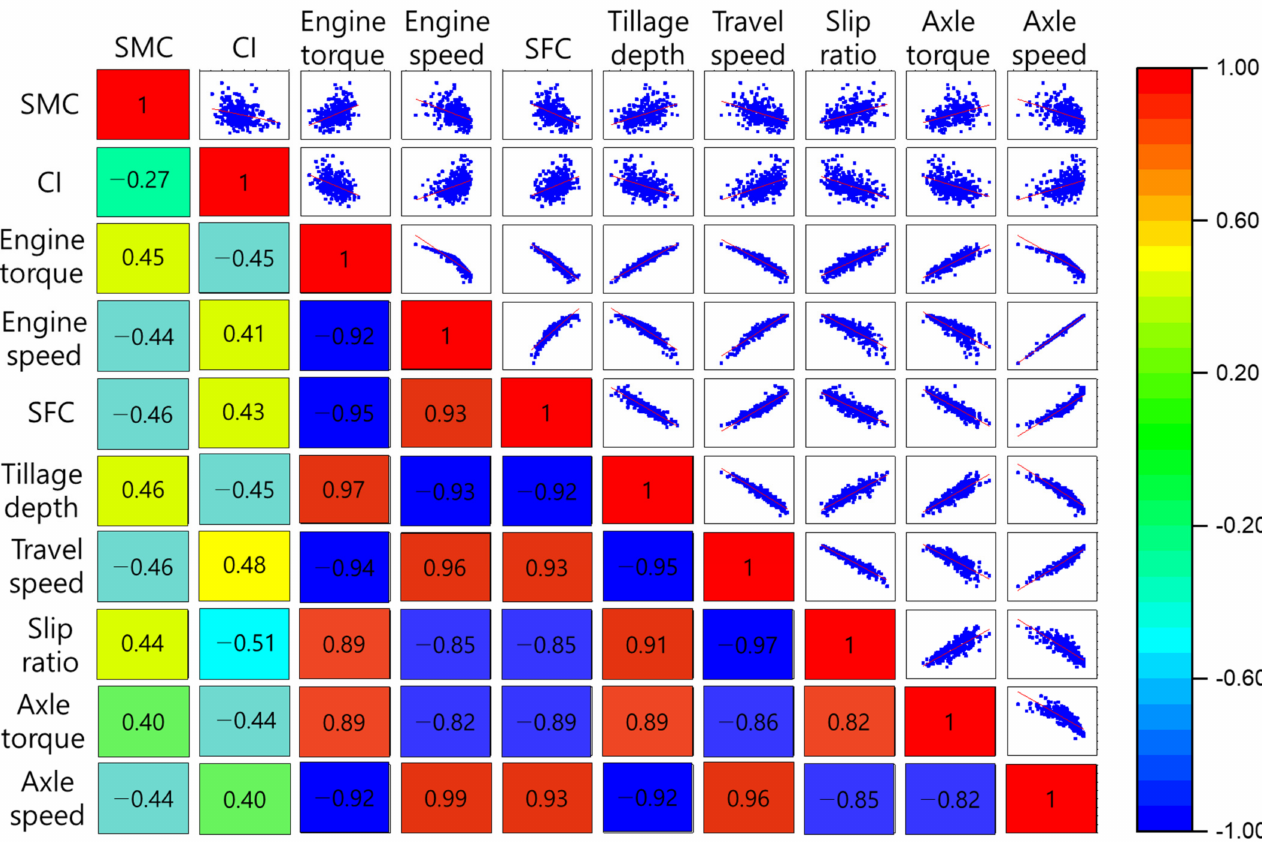
Figure 3. Correlation matrix plot between soil physical properties and major tractor